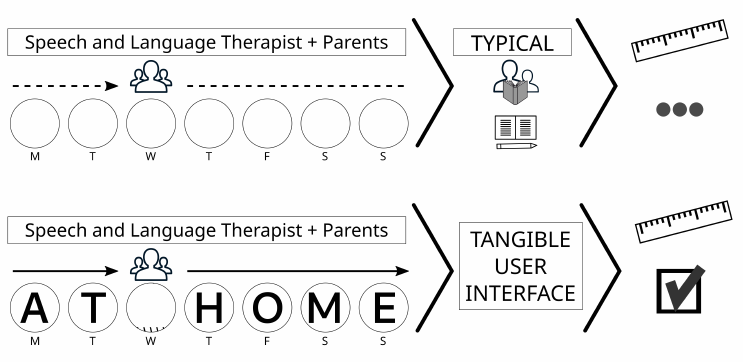
Figure 1. The typical schema ( top ) of a speech and language therapy session—once a week, unmoni- tored at-home activities versus ( bottom ) the proposed approach of using a TUI for monitored and engaging at-home activities. Adapted from